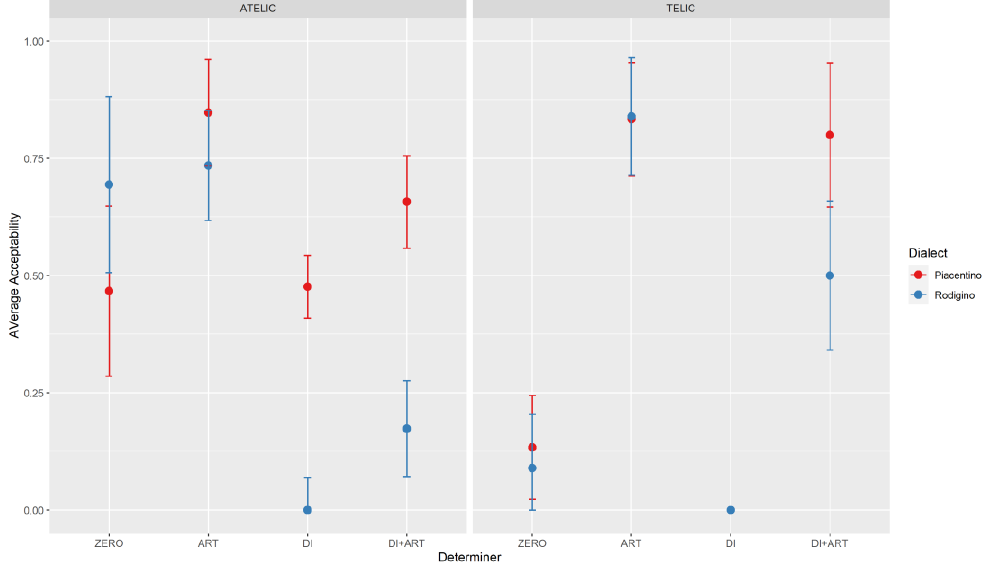
Figure 7. Average acceptability scores by determiner type and speaker’s dialect in sentences with an atelic (left) or telic (right) verb. For the sake of brevity and to avoid redundancy, only the acceptability scores from the by-subject analysis are